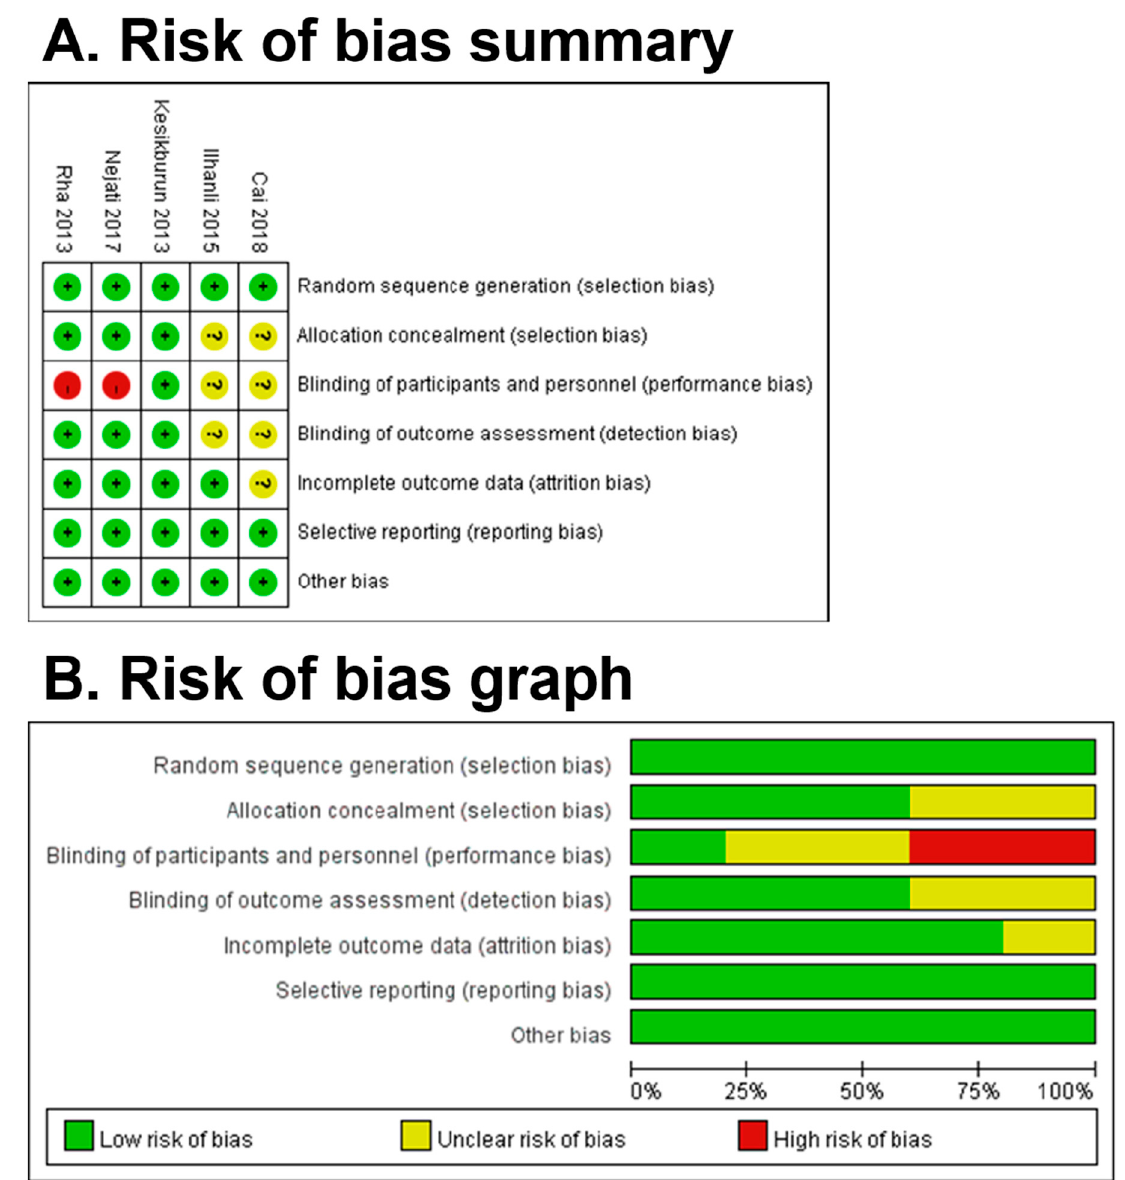
Figure 2. Risk of bias summary ( A ) and graph ( B ). Green, low risk of bias; red, high risk of bias; yellow, unclear risk of bias.